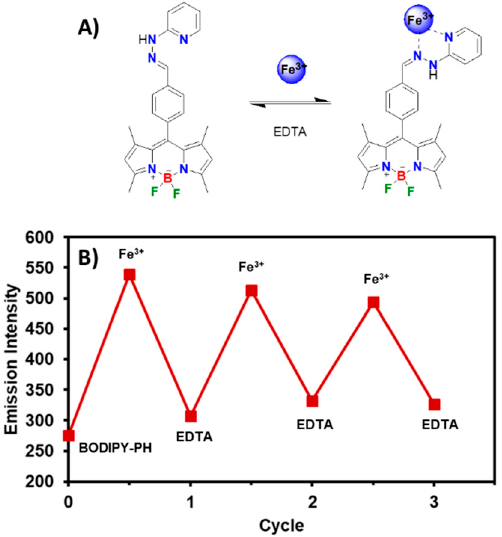
Figure 11. ( A ) The proposed binding mode between BODIPY-PH and Fe 3+ and its reversible reaction through EDTA complexation. ( B ) Reversible changes in fluorescence intensity of BODIPY-PH (10 µM) at 518 nm upon alternate addition of Fe 3+ (100 µM) and EDTA (100